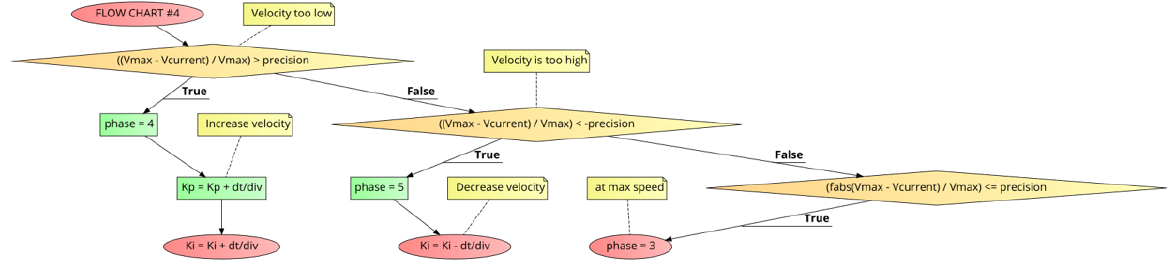
Figure 11. PID++ Flow Chart #4—second half of run (plateau before the end of run deceleration